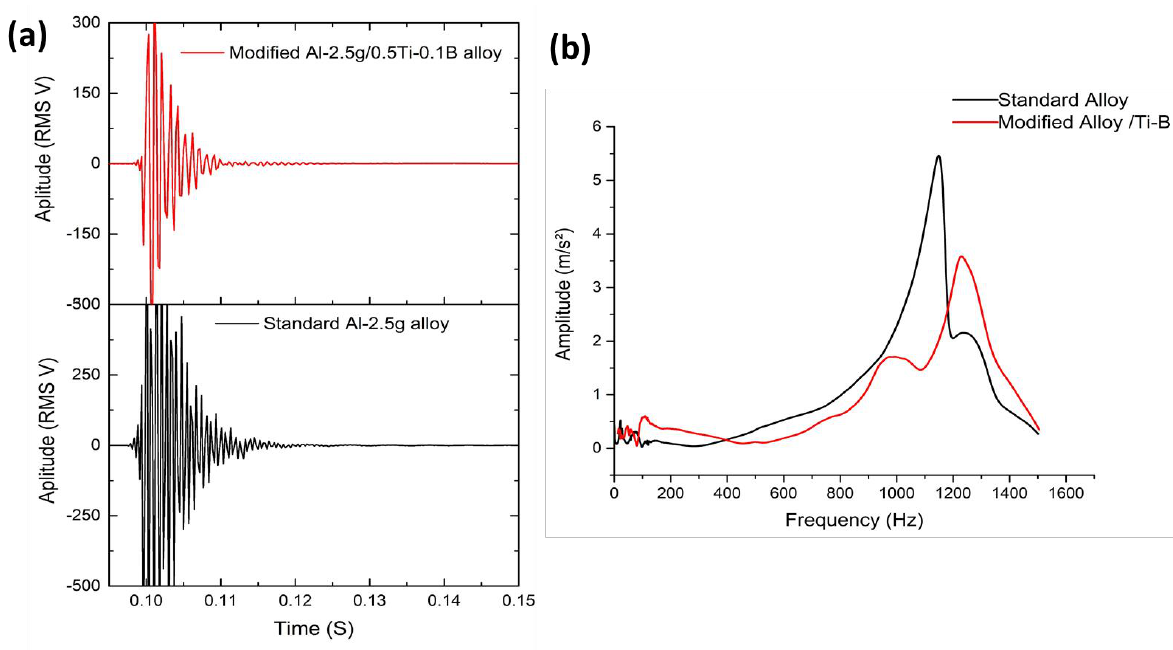
Figure 12. Graphical representation of the simulation results of the resonant frequencies at the first six modes.